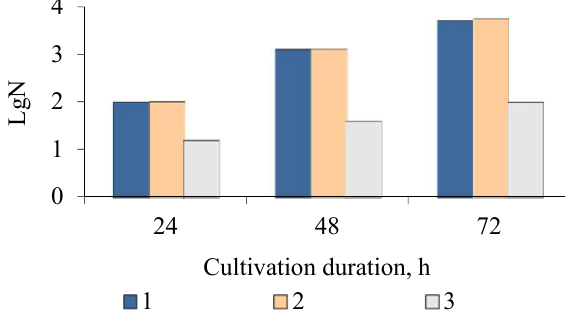
Fig. 2. Dynamics of the number of Bifidobacterium adolescentis MC 42 (lgN) cells in the nutrient medium that contains cedar oil (1.0% emulsion in water) after 24 h, 48 h and 72 h of fermentation: (1) oil (cold pressing); (2) oil (heat pressing); (3) control (a culture medium that does not contain any potential antioxidant agents). The data are expressed as a mean ± standard deviation ( n = 5).